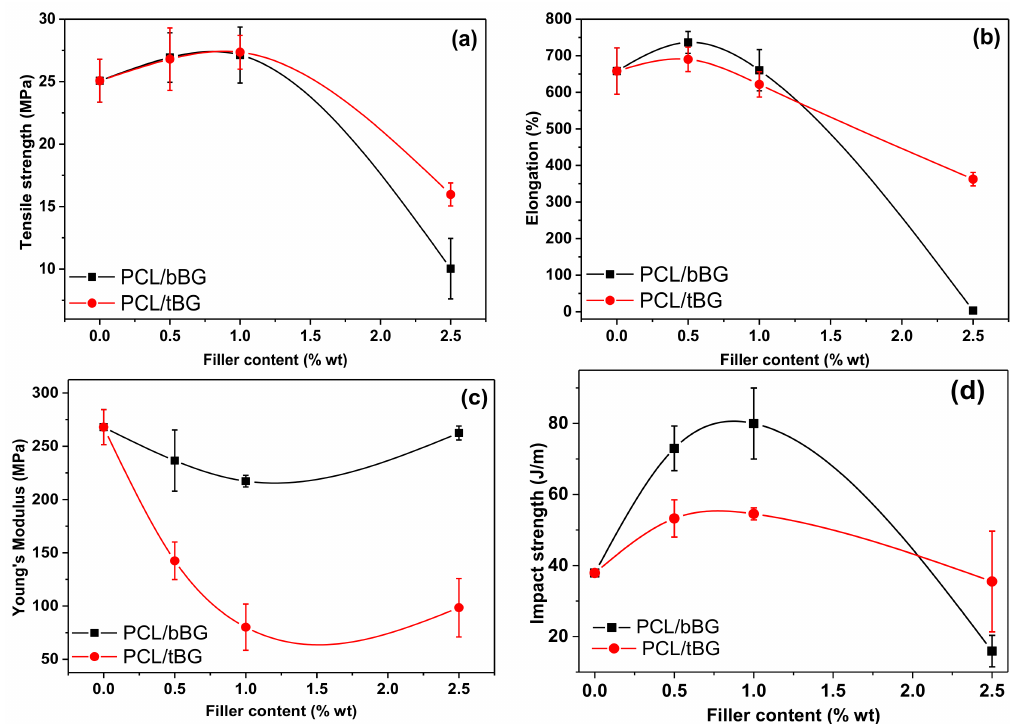
Figure 10. Effect of nanofiller type and content on ( a ) tensile stress at break, ( b ) elongation at break, ( c ) Young’s Modulus and ( d ) impact strength of PCL nanocomposites. The lines are just a guide to the eye.